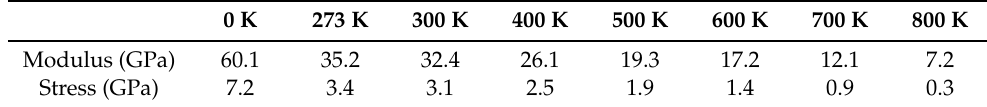
Figure 3. Calculated modulus of perfect aluminum crystals at different temperatures. Table 2. Modulus and stress values of perfect aluminum crystals at different